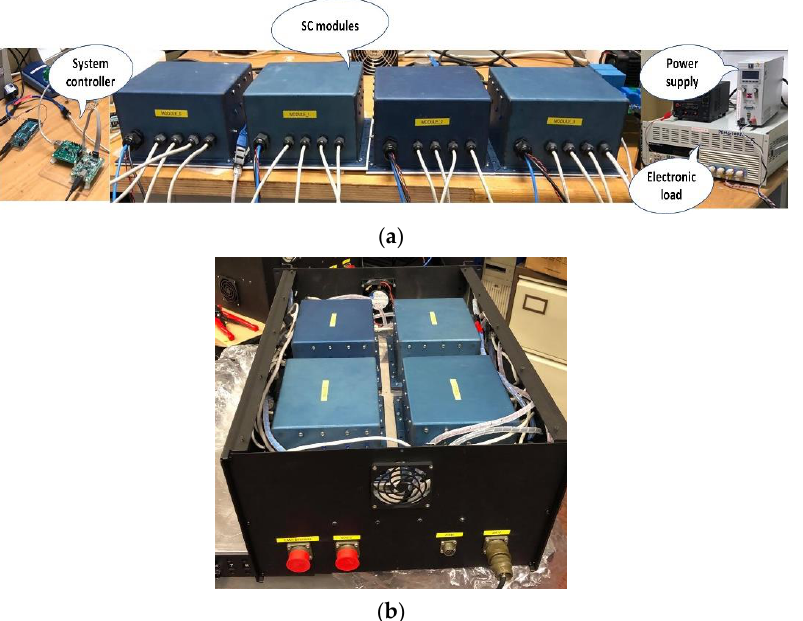
Figure 8. Experimental setup to validate the proposed design for SC-ESS: ( a ) test setup; ( b ) assembled SC-ESS